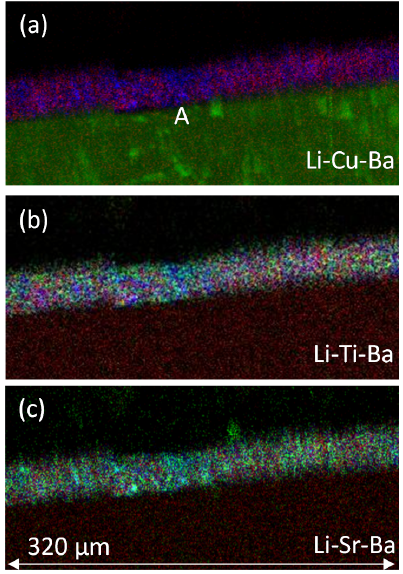
Figure 8. Three ‐ colour maps. ( a ) Li ‐ Cu ‐ Ba, ( b ) Li ‐ Ti ‐ Ba and ( c ) Li ‐ Sr ‐ Ba. In all cases, the Li is red, the barium is blue, the middle element is green; i.e., green changes from top to bottom as Cu, Ti and Sr.